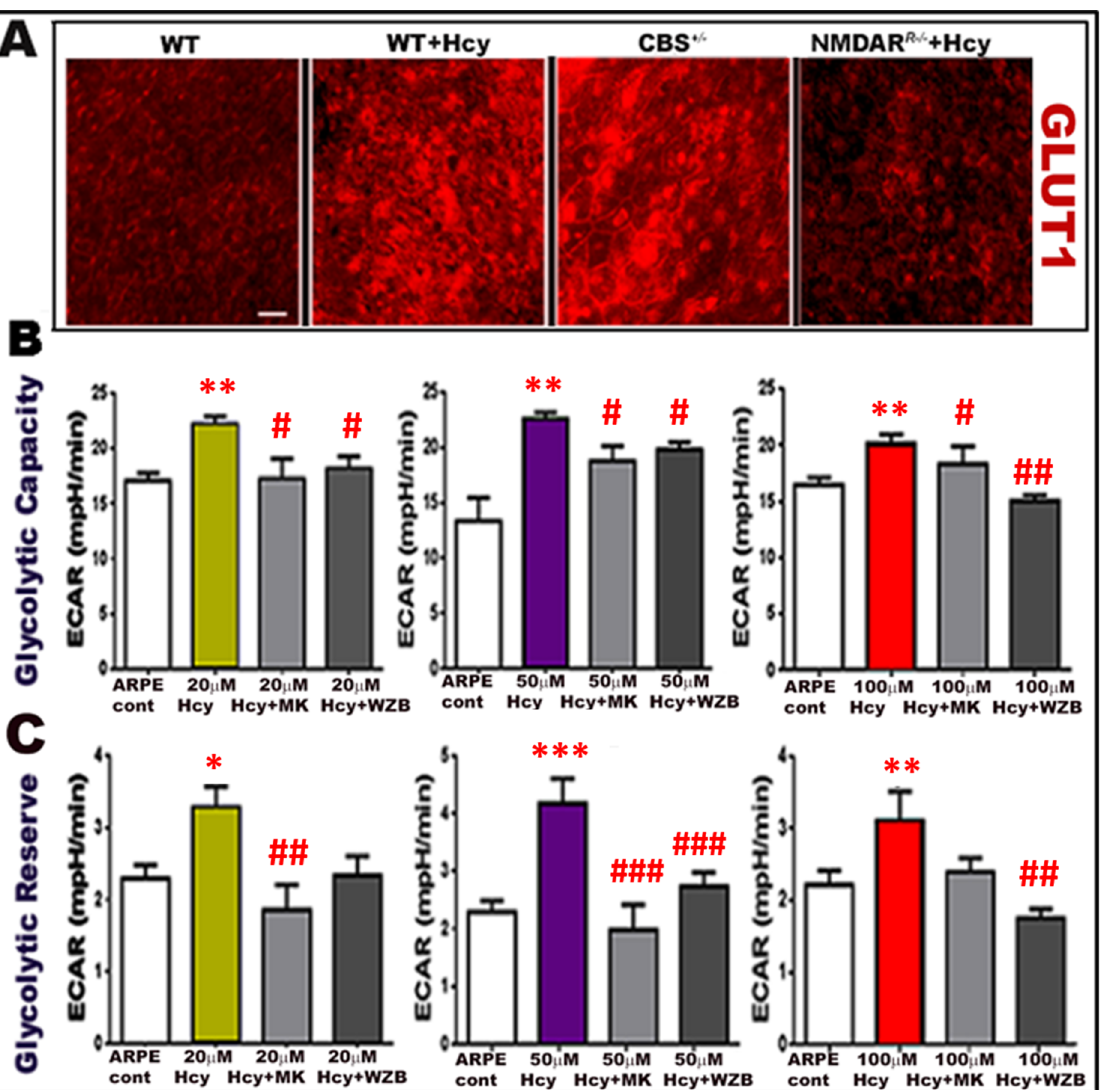
Figure 7. Deletion of NMDAR in RPE cells decreased Hcy-induced activation of glycolysis. ( A ) immunofluorescence staining for RPE flat mounts isolated from mouse retinas after one week of intravitreal injection of Hcy in WT and NMDAR R − / − compared to WT-control non-injected mice and mice with HHcy ( cbs + / − ) stained with the marker for GLUT1 (red). Hcy injection induced activation of GLUT1, which was more evident in both mice models of HHcy ( cbs +/ − mice and Hcy-injected WT mice), while knocking down NMDAR (in NMDAR R − / − ) was able to reduce the activation of GLUT1 induced by Hcy-injection. ( B ) Glycolytic capacity and ( C ) Glycolytic reserve evaluated by seahorse analysis for ARPE-19 cells treated with different concentrations of Hcy (20, 50, and 100 μ M) in the presence /or absence of NMDAR inhibitor MK801or GLUT1 inhibitor WZB117. * p < 0.05, ** p < 0.01, and *** p < 0.001 (Hcy treated group compared to ARPE-control group) while # p < 0.05, ## p < 0.01, and ### p < 0.001 (Hcy + MK treated RPE and Hcy + WZB treated RPE compared to Hcy treated group) for all concentrations.